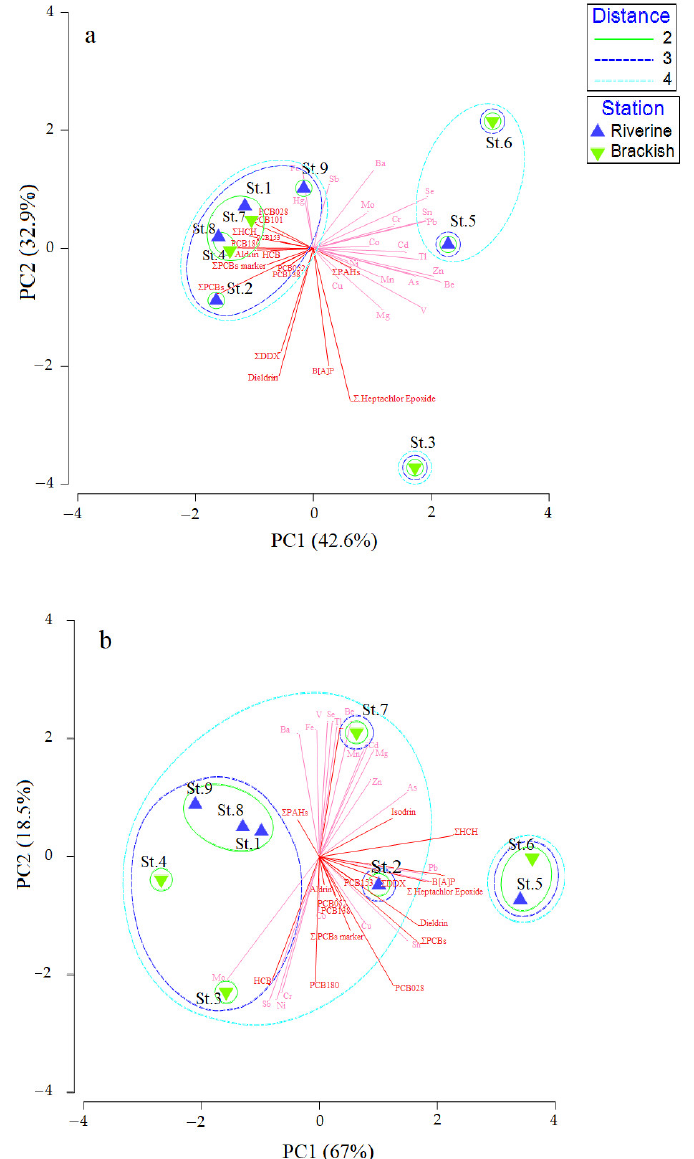
Figure 5. Principal Component Analysis computed on Euclidean distance calculated with envi- ronmental data recorded in the Pasvik River during Ice-melt( − ) ( a ) and Ice-melt(+) ( b ) conditions. Vectors from inorganic and organic pollutant concentrations have been superimposed (Correlation type Pearson).